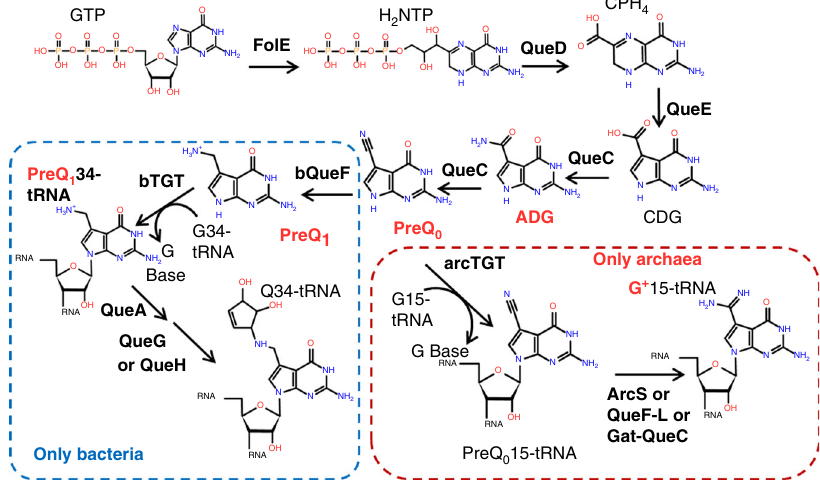
Fig. 1 Queuosine and archeosine synthesis pathways. preQ 0 is synthesized from GTP in both bacteria and archaea through FolE, QueD, QueE, and QueC, as shown. In most bacteria, four more enzymatic steps lead to the insertion of Q in tRNAs at position 34 (blue dashed square). In archaea, preQ 0 is transferred to position 15 of tRNA before being modi fi ed to G + (red dashed square). The bases found in phage DNA in this study are in red. Molecule abbreviations: guanosine tri-phosphate (GTP), dihydroneopterin triphosphate (H 2 NTP), 6-carboxy-5,6,7,8-tetrahydropterin (CPH 4 ), 7-carboxy-7- deazaguanine (CDG), 7-amido-7-deazaguanine (ADG), 7-cyano-7-deazaguanine (preQ 0 ), 7-aminomethyl-7-deazaguanine (preQ 1 ), queuosine (Q), and archaeaosine (G +